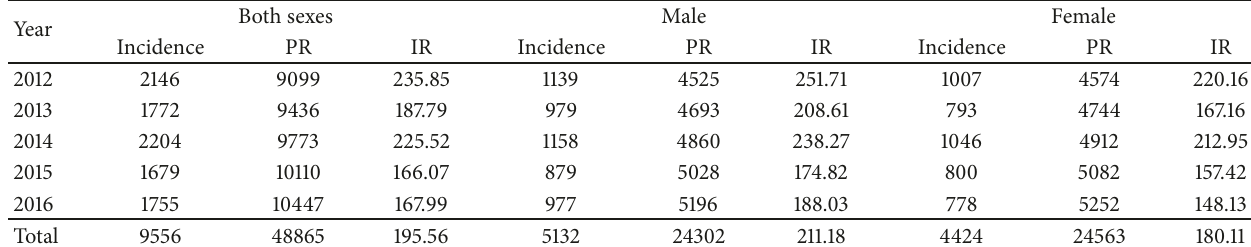
Table 3: Children under-five population incidence rate of diarrhea cases by sex in the Jasikan District from 2012-2016.